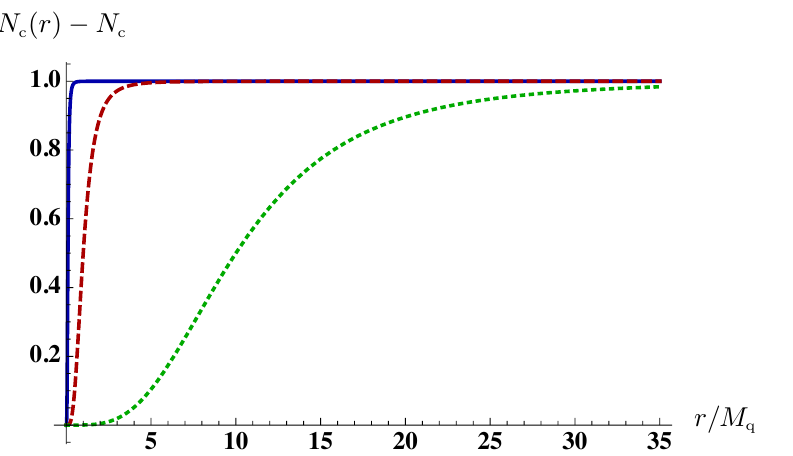
Figure 2. E(cid:11)ective number of D3-branes on the D7-branes within a sphere of radius r | see (2.56) | for (cid:3) =M = f 1 = 10 ; 1 ; 10 g (solid blue, dashed red and dotted green curves, q